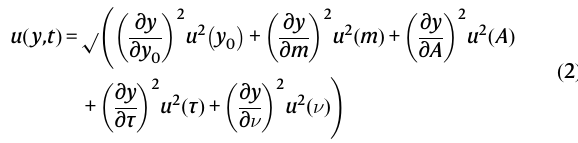
Where θ ( t ) is the Heaviside theta function. A is amplitude of the var- iation, τ is the decay time, and T is the oscillationperiod. Table 1 shows the fi tted values for the three data series. Data shown in the text have been obtained by subtracting the small, linearly varying background and normalizing the values for the unperturbed transmission. The con fi dencebandsofthe fi thavebeencalculatedusingthepropagation of uncertainty on the fi tted quantities according to the following for- mula.